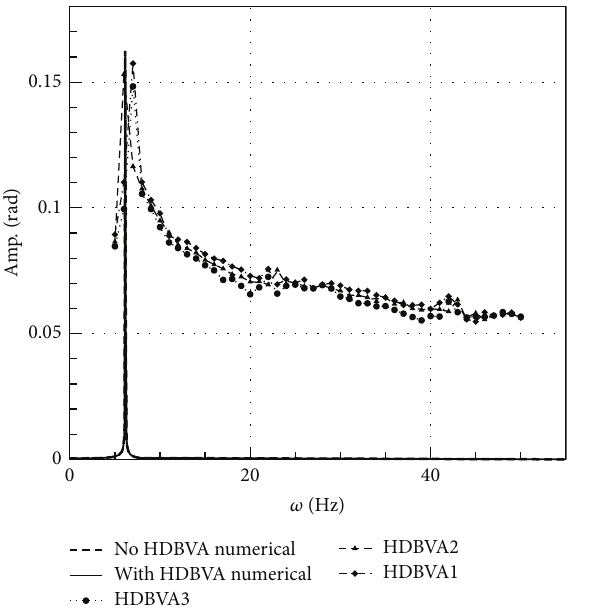
Figure 22: Frequency response of 𝜃 𝑍 DOF of case Figure 10(a), HDBVAs start at the near-force point.